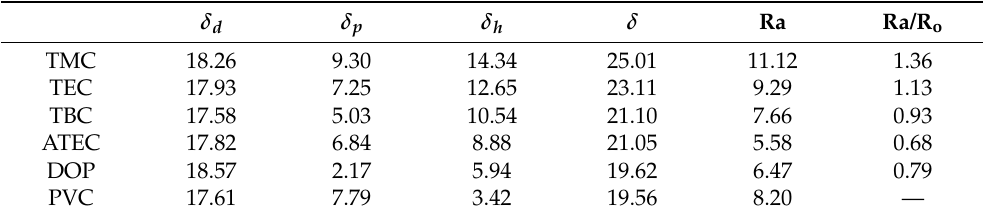
Table 2. Calculation results of Hansen solubility parameters of plasticizers and the Ra/R o values. δ d δ p δ h